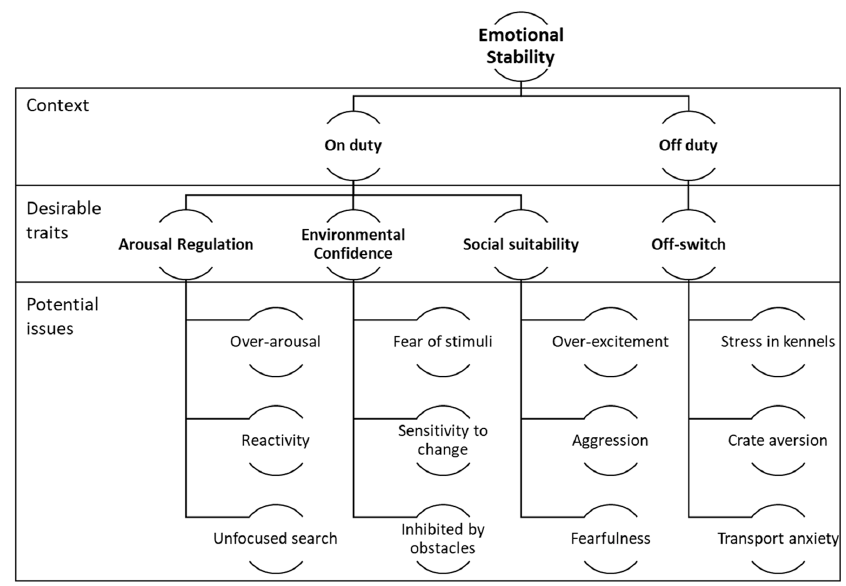
Figure 2. Emotional stability traits and descriptors in biosecurity detector dogs as described by focus group participants.